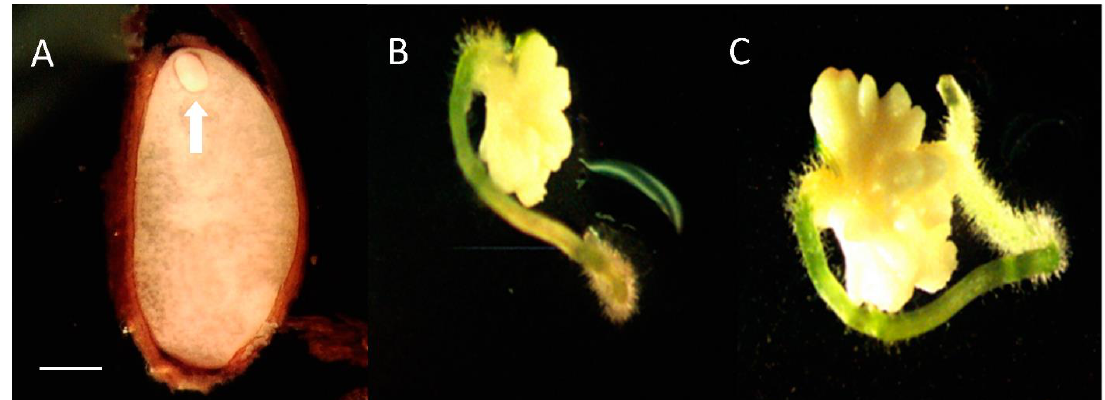
Figure 2. Xerophyllum asphodeloides seed with embryo. ( A ) Unstained embryo before isolation (arrow). ( B ) Embryo excised from sterilized seeds growing on ½ MS without PGRs medium 35 days after placement on medium. ( C ) 56 days after placement on medium. Scale bar = 1 mm.